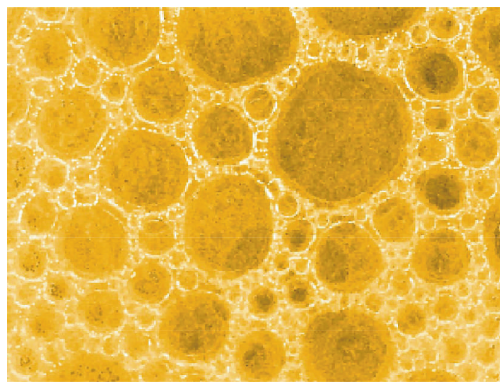
Figure 3.5. Apollonian foam at the inner walls of a plane beer glass.